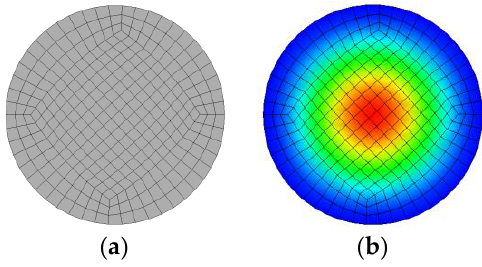
Figure 2. The membrane. ( a ): the finite element model and ( b ): the first mode with 𝑓 0 = 5.08⁡𝐻𝑧